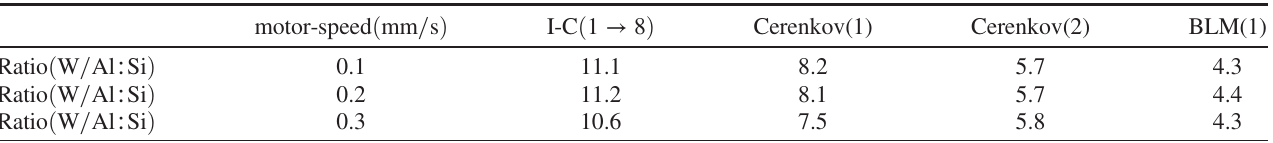
TABLE III. Ratio — W against Al ð 99 Þ ∶ Si ð 1 Þ — of the radiation-dose measured by three different detector when scanning the electron beam — 700 pC at 1.325 GeV — with a 12 . 5 μ m Al ð 99 Þ ∶ Si ð 1 Þ wire and a 5 μ m tungsten wire at motor-speeds of 0.1, 0.2 and 0 . 3 mm = s. Radiation-dose measurements are performed: by a set of 8 Ionization-Chambers (I-Cs) located in front, behind and in between the 7 undulator composing the FEL1 undulator chain; by 2 Cerenkov fibers — Cerenkov(1,2) — which are stretched along the FEL1 vacuum chamber; finally, by a scintillator fiber — BLM(1) — placed at 2.48 m from the